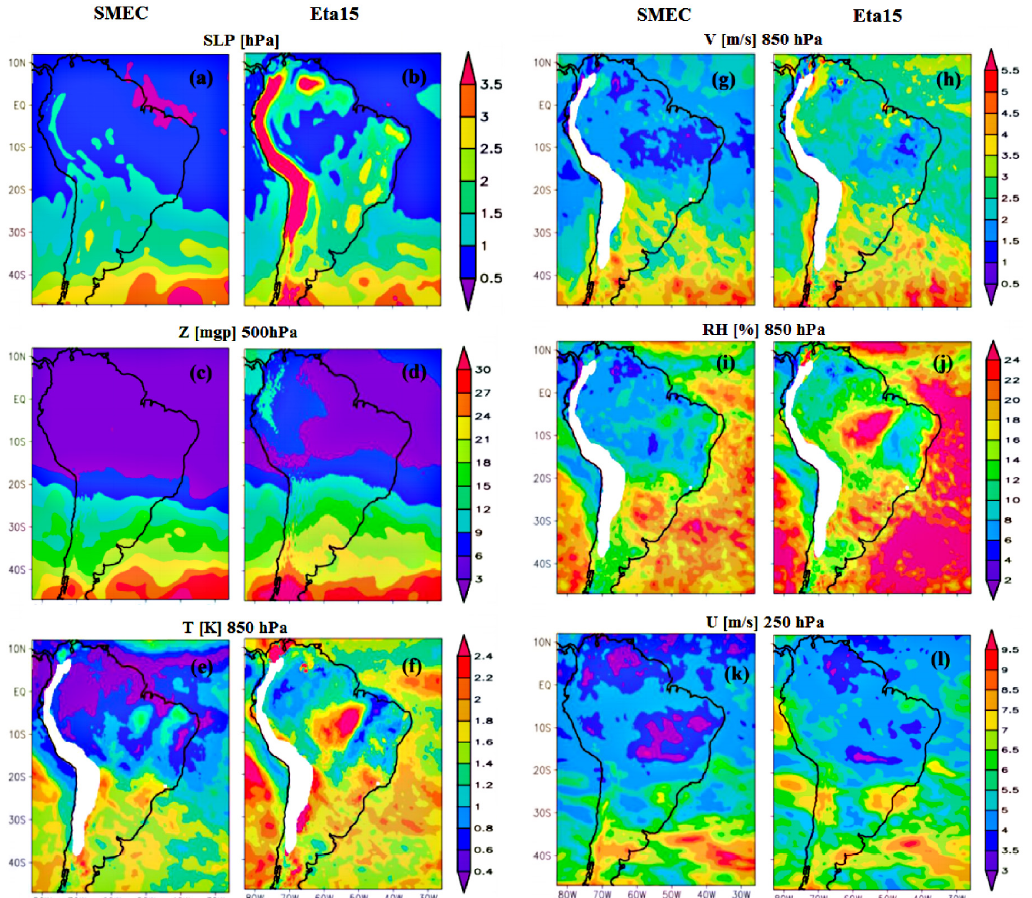
Figure 8. Spatial distribution of the RMSE at 48h of integration for the winter period for SMEC (left column) and Eta15 (right column), for mean sea level pressure (a, b) , 500hPa geopotential height (c, d) , 850hPa air temperature (e, f) , 850hPa meridional wind (g, h) , 850hPa relative humidity (i, j) and 250hPa zonal wind (k, l)